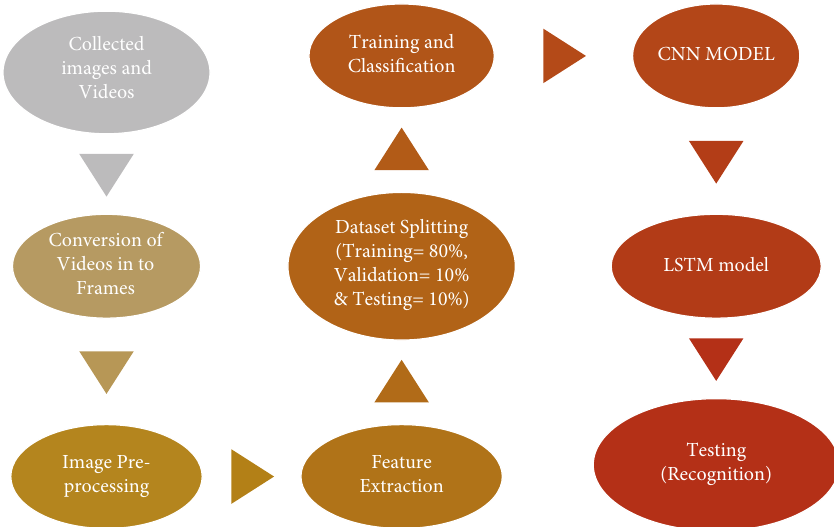
Figure 7: The proposed Ethiopian finger spelling recognizer model’s system architecture representation of shapes, contour-based and region-based shapes are used. Features are extracted from the contour only in the case of contour-based classification and extracted from the whole shape region for the region-based classification [11].